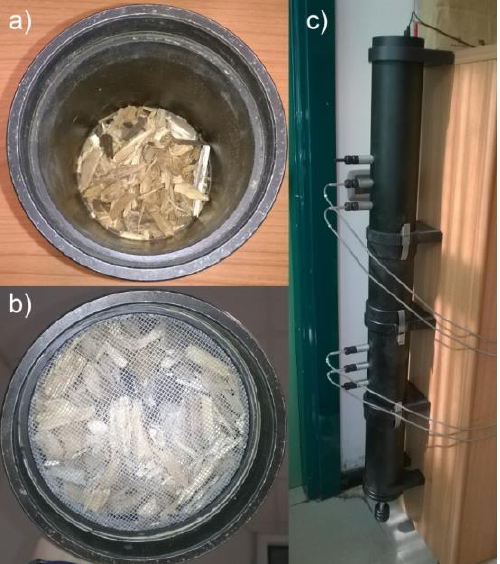
Figure 10. ( a , b ) Specifically designed sample holder; and ( c ) Tube configuration for transmission loss measurements.